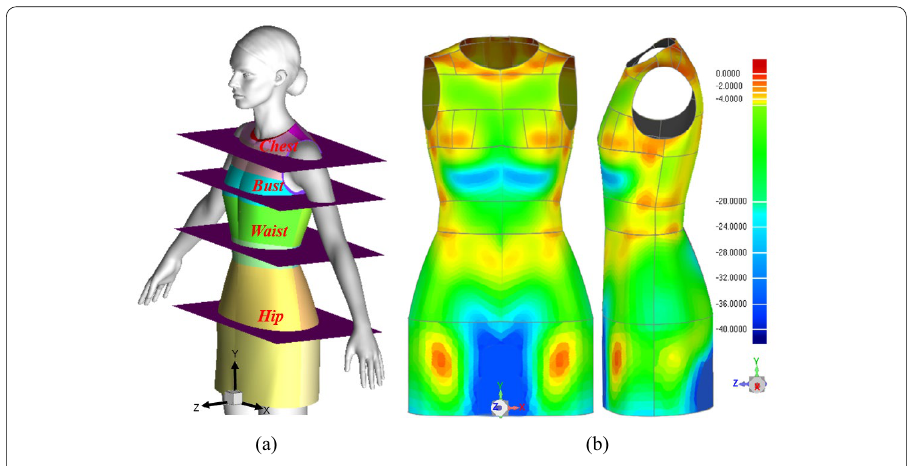
Fig. 3 Landmarks and air gap. a Horizontal cross-section and cut lines, b air gap distance contours